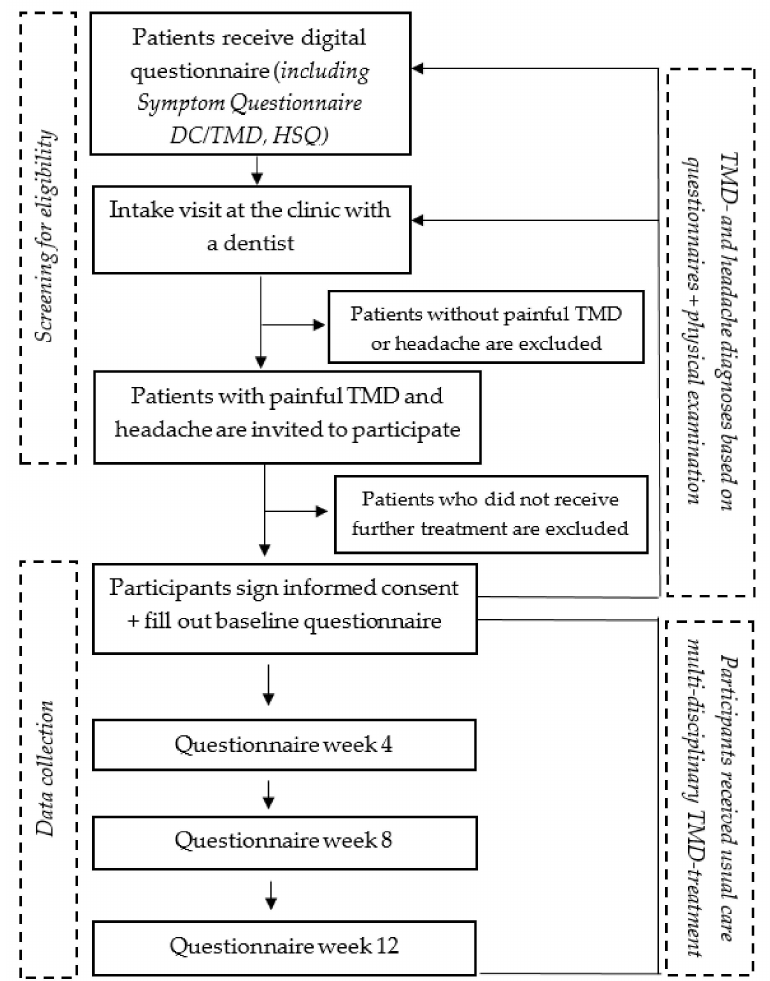
Figure 1. Flow of the study design, portraying each step the participants take within this study. DC/TMD: diagnostic criteria for temporomandibular disorders; HSQ: headache screening question-